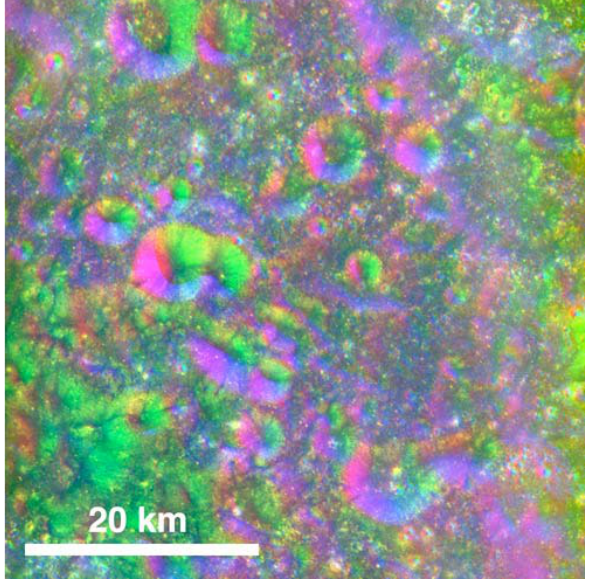
Figure 3. Comparison of time-corrected and orthorectified bistatic image of the lunar south polar region (blue) with east- looking (green) and west-looking (red) controlled mosaics of monostatic images for the region outlined in Fig. 1. Projection is the same as in Fig. 1 with north approximately at